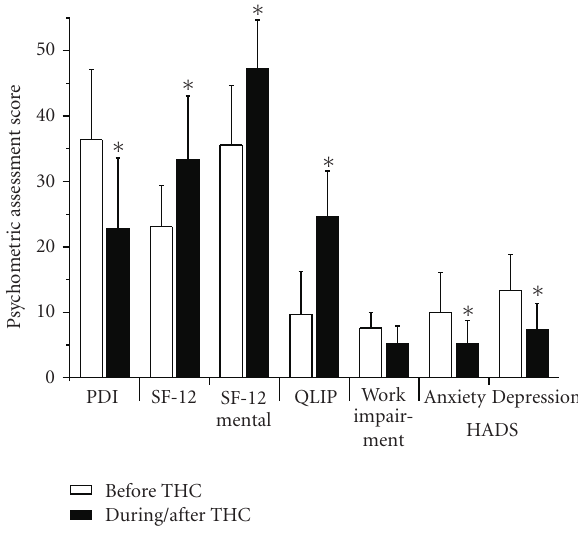
Figure 2: Psychometric assessment of the patients before (white bar) and during/after (black bar) delta 9-THC therapy. Particularly Pain Disability Index (PDI), Quality of Life (QLIP), and Hospi- tal Anxiety Depression Scale (HADS) improved significantly in response to delta 9-THC